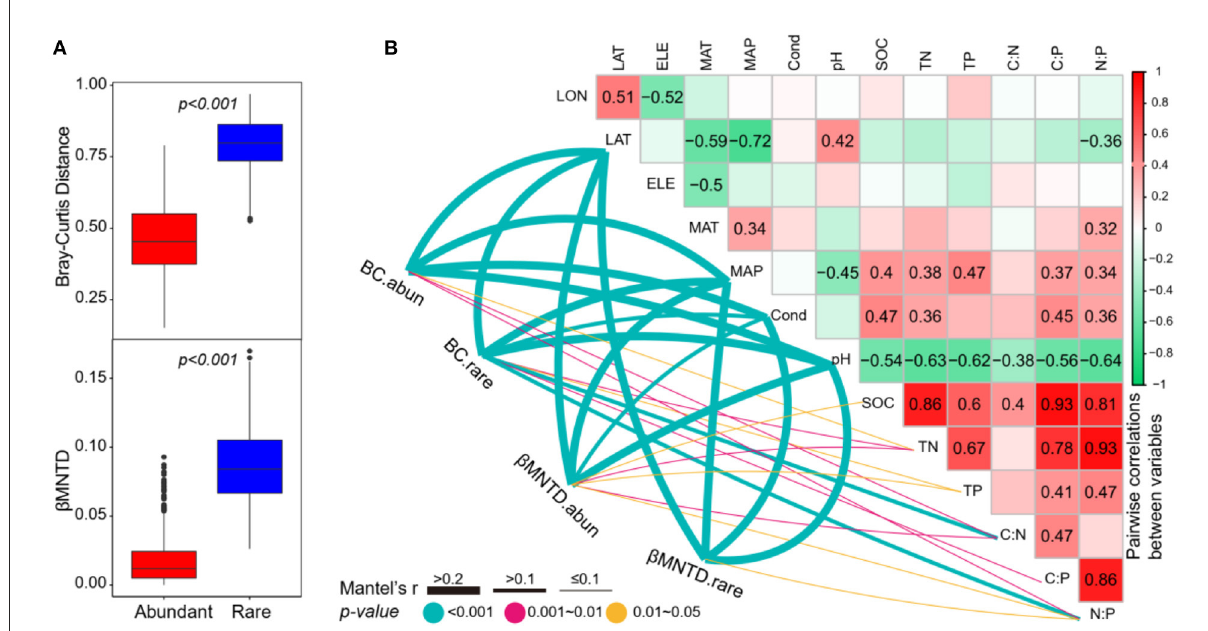
FIGURE5 (A) The differences of the Bray–Curtis distance and β MNTD between abundant and rare subcommunities (Wilcoxon rank-sum test, p < 0.001). (B) Pairwise correlations between environmental variables, and the Mantel tests between environmental variables vs. β -diversity. BC.abun, BC.rare, β MNTD.abun, and β MNTD.rare represent the Bray–Curtis distance and β MNTD of abundant and rare subcommunities, respectively. The lines denote the significant relationships with line width representing the Mantel r statistic. Pairwise correlations between environmental variables are shown in the heatmap matrix denoting Pearson’s correlation coefficient. The significant results are shown in numbers. The abbreviations of the environmental variables are explained in the Methods